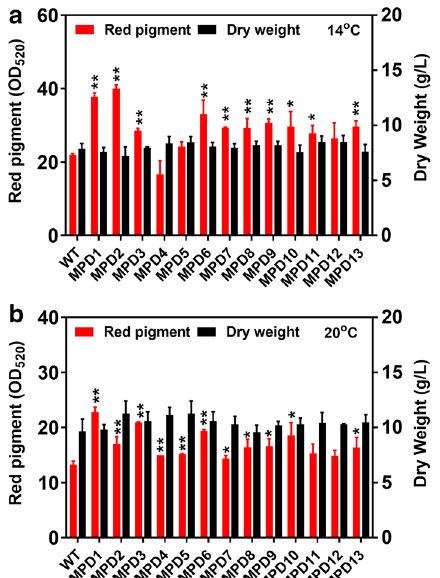
Fig. 4 Red pigment production and cell growth of MPD1–MPD13 mutants obtained by dual transposable systems. a The red pigment production and its dry weight of the mutants at 14 °C. b The red pigment production and its dry weight the mutants at 20 °C. The value of the bar represents the highest pigment level or the highest biomass dry weigh at culture duration. Determination of absorbance value of red pigment at wavelength of 520 nm (OD 520 ). Data of significance were shown in ** P < 0.01 and * P < 0.05